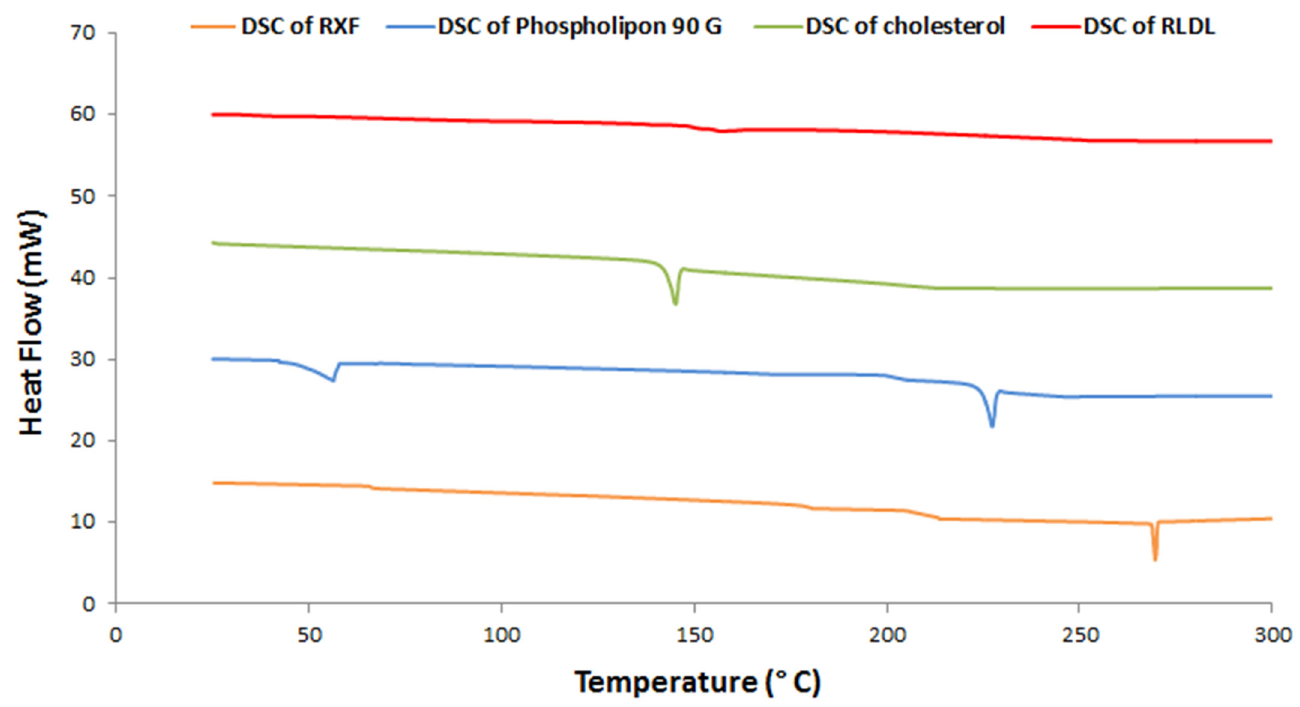
Figure 2. In vitro permeation profiles of RXF from free RXF and different RLDL formulations ( n = 3 ± SD).